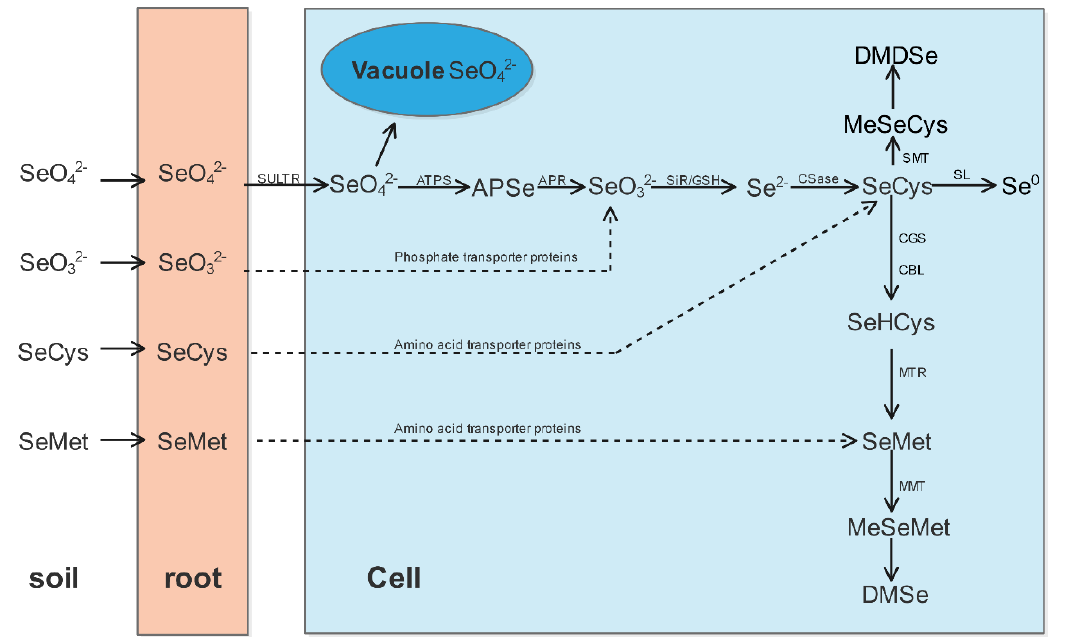
Figure 1. The main ways plants absorb and assimilate selenium. Note: SULTR, sulfate transporter; ATPS, ATP sulfurylase; APSe, adenosine 5′-phosphoselenate; APR, adenosine 5′-phosphosulfate reductase; SiR, sulfite reductase; GSH, glutathione; CSase, cysteine synthase; SMT, selenocysteine methyltransferase; SL, selenocysteine lyases; CGS, cystathionine-γ-synthase; CBL, cystathionine β-lyase; MTR, methionine synthase; MMT, methionine methyltransferase; SeCys, selenocysteine; SeMet, selenomethionine; SeHCys, Se homocysteine; SeMSeMet, methyl selenomethionine; SeMSeCys, methyl selenocysteine; DMSe, dimethyl selenide; DMDSe, dimethyl diselenide.